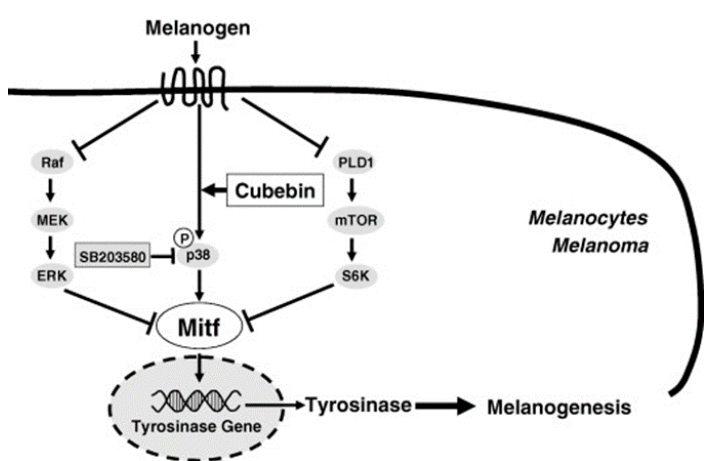
Figure 35. A proposed scheme showing the activation mechanism of cubebin on melanogenesis [107].